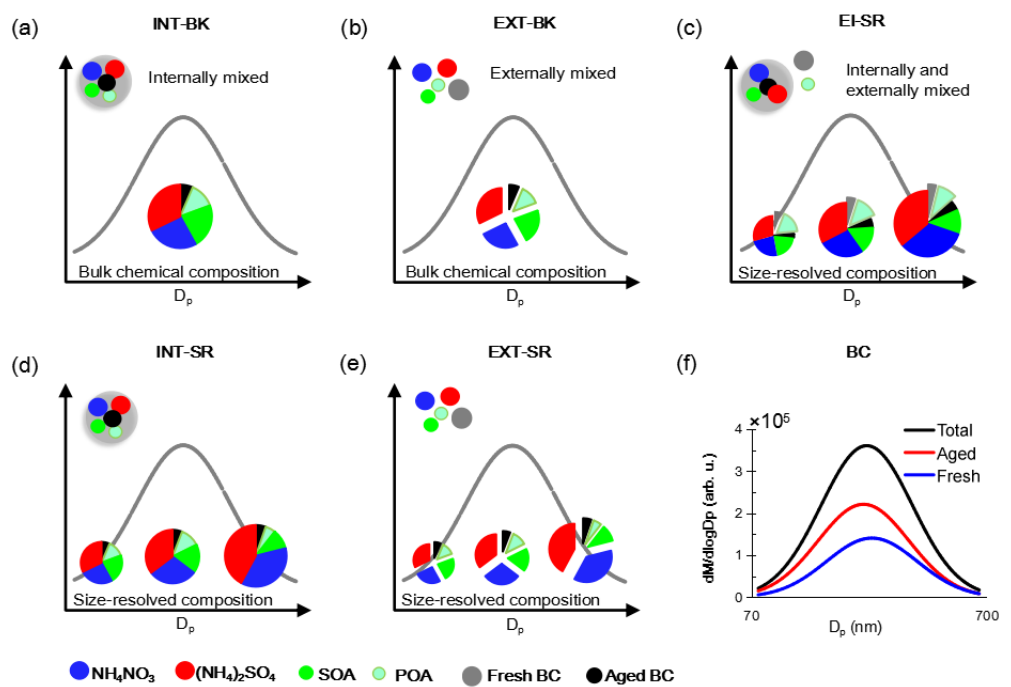
Figure 1. Schematic representation of the five different schemes: (a) INT–BK, (b) EXT–BK, (c) EI–SR, (d) INT–SR, and (e) EXT–SR, in addition to (f) the BC size distribution used in this study. The fresh and aged BC size distribution are retrieved from the total BC size distribution measured by the SP2 (Wu et al., 2017) and the dependence of the fraction of internally mixed soot ( F in ) on particle diameter ( D p ) observed in urban Beijing (Cheng et al., 2012). The total BC size distribution is used in the INT–SR and EXT–SR schemes, and the aged and fresh BC distributions are used in the EI–SR scheme. In the EI–SR scheme, some BC particles are assumed to already be aged and thus internally mixed with sulfate, nitrate, and SOA, and some of them together with POA are freshly emitted and assumed not yet aged/coated by other species (externally